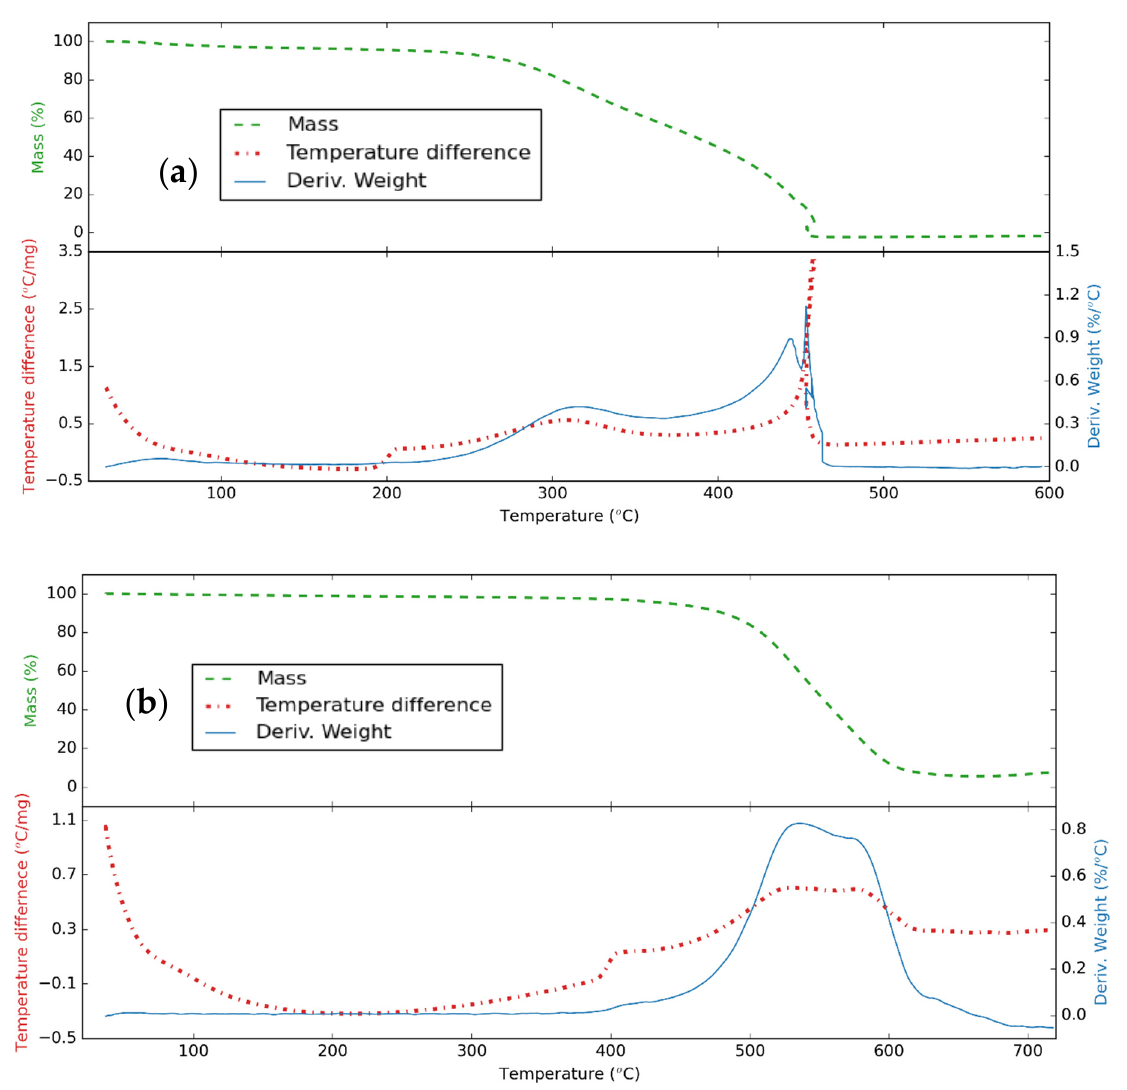
Figure 4. Thermal analysis curve for ( a ) CNS and ( b ) CNP with a heating rate of 10 °C/min in airflow.